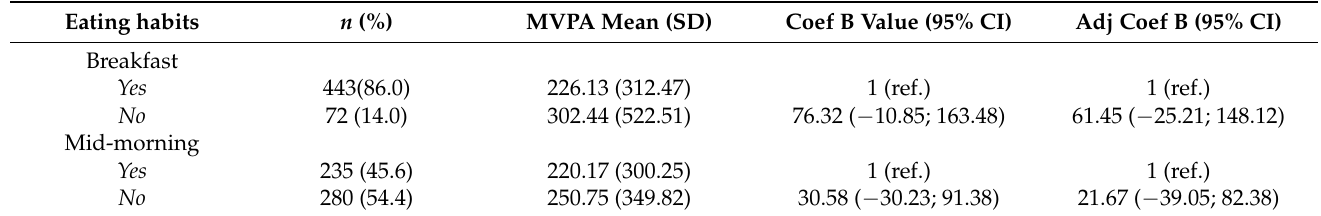
Table 4. Weekly physical activity and food consumption unadjusted and adjusted for sex, age and